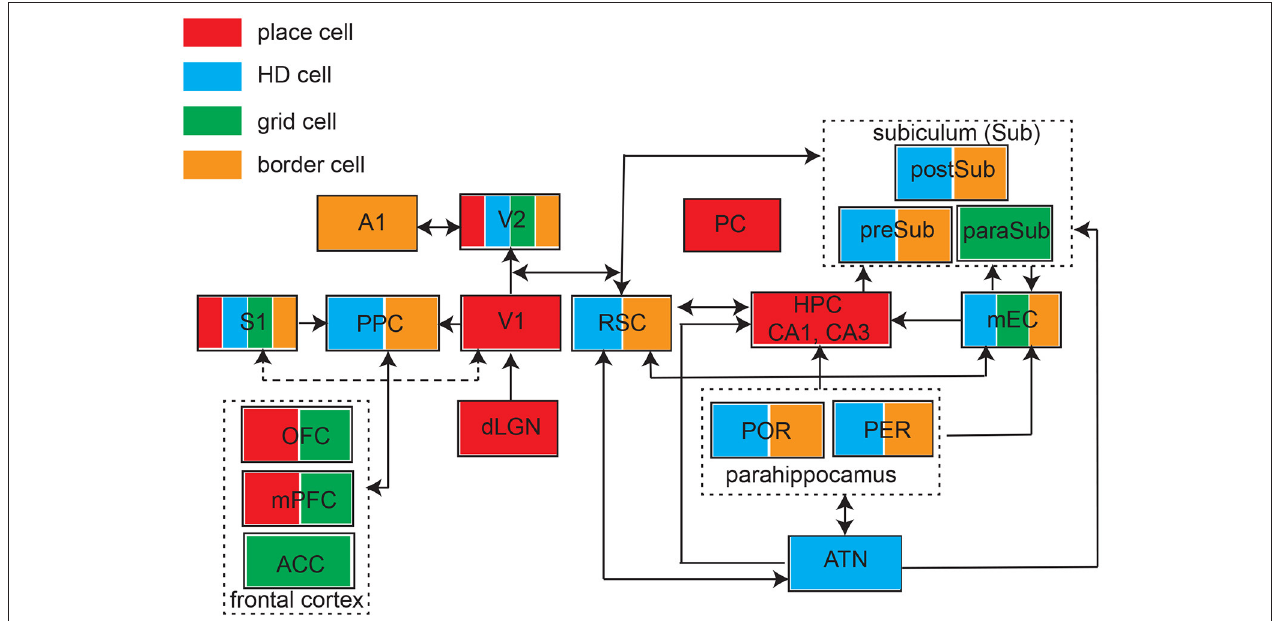
FIGURE 3 | Schematic of identified brain structures with four major types of spatial tunings. ATN, anterior thalamic nuclei; S1, primary somatosensory cortex; PPC, posterior parietal cortex; V1, primary visual cortex; V2, secondary visual cortex; A1, primary auditory cortex; PC, piriform cortex; RSC, retrosplenial cortex; HPC, hippocampus; mEC, medial entorhinal cortex; POR, postrhinal cortex; PER, perirhinal cortex; preSub, presubciculum), paraSub (parasubiculum); postSub, postsubiculum; OFC, orbitofrontal cortex; mPFC, medial prefrontal cortex; ACC, anterior cingulate cortex. Arrow indicates the